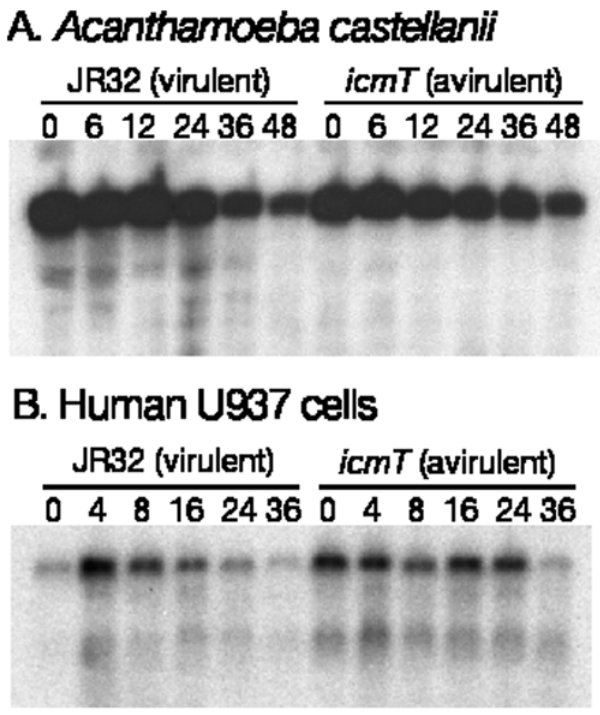
Figure 5. No LSU rRNA cleavage in Acanthamoeba or human cells during L.pneumophila infection. (A) A. castellanii (ATCC 30234) were infected by L. pneumophila in Ac buffer at 37 u C. (B) Human U937 cells (ATCC CRL-1593.2) were infected by L. pneumophila . Total RNA samples were probed on northern blots with a A. castellanii or human mitochondrial LSU rRNA probes. In each experiment, the infection was confirmed by monitoring the internalization of GFP-labeled bacteria and host cell killing (data not shown). Experiments were carried out three times and a representative experiment is shown.